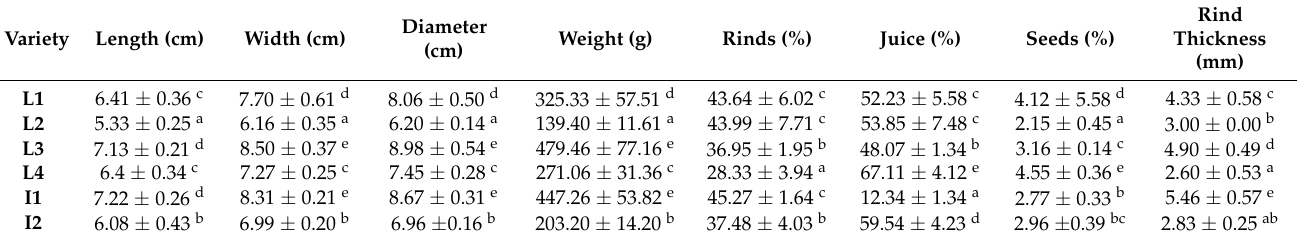
Figure 1. “Djeibi” (L1), “Mersi” (L2), “Sefri 1” (L3), “Sefri 2” (L4), “Mollar de Elche” (I1), and “Hicaz” (I2) pomegranate varieties. Table 1. Mean ( n = 15) values of physical characteristics of analyzed pomegranate cultivars.